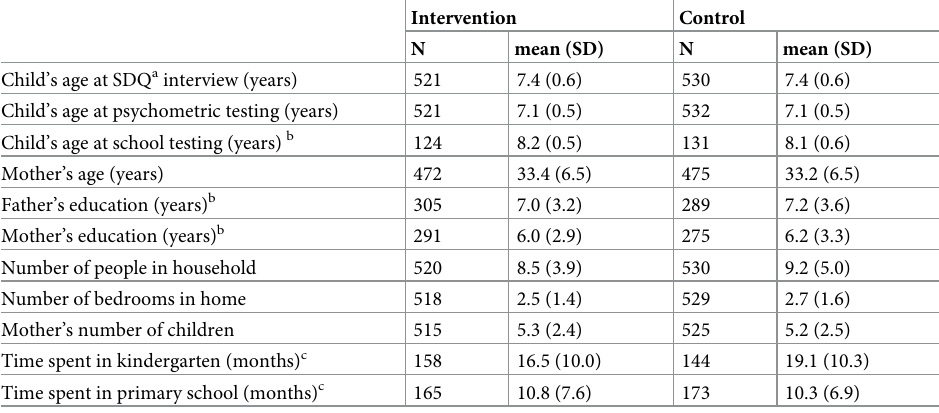
Table 1. Baseline characteristics, continuous variables given. Intervention